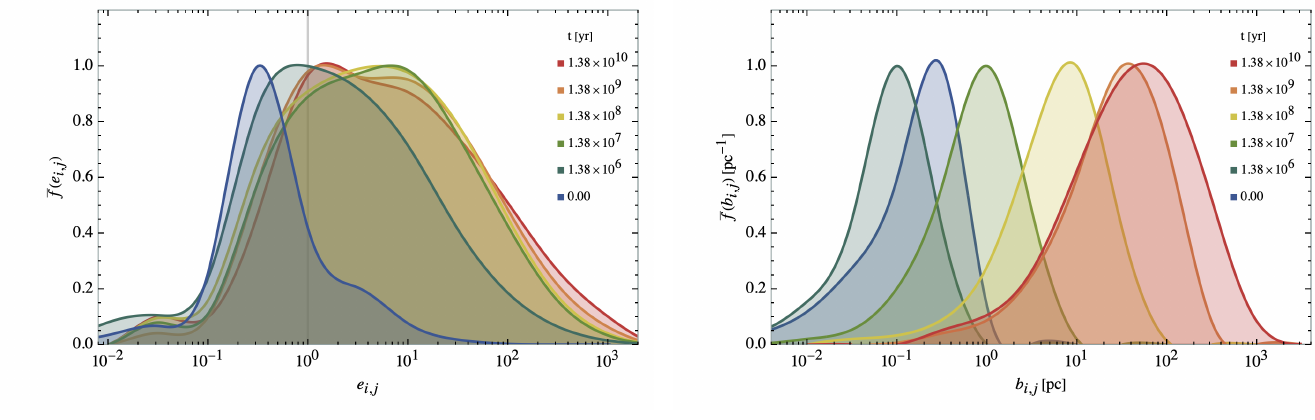
Figure 16. Shown are the relative orbital eccentricity and impact distributions for the identified two-body encounters at selected times. These are computed by taking, for each realisation, the 100 PBHs closest to the cluster barycenter and calculating the array of 100 × 100 relative eccentricities among them, for the 6 time slices that split the last four runs and the IC. Fits for the distributions are given in Table 18. Table 18. Nearby objects eccentricity and impact parameter distributions of Figure 16 distribution Log-Normal fits: the standard deviation of the z variable’s natural logarithm at selected times, and P = C,E stands for the cluster and ejecta populations, respectively, and z = e , b for the mass, position and velocity functions. Note that, fits to Rayleigh χ 2 and Maxwell–Boltzmann χ 2 distributions have also been tried for the position and velocity profiles, having found that, 3 except for those time slices before the burn-in time, a Log-Normal fit beats the former trials. Whenever none of the above fits meaningfully describe the data, r 2 < 0.8, no fit is